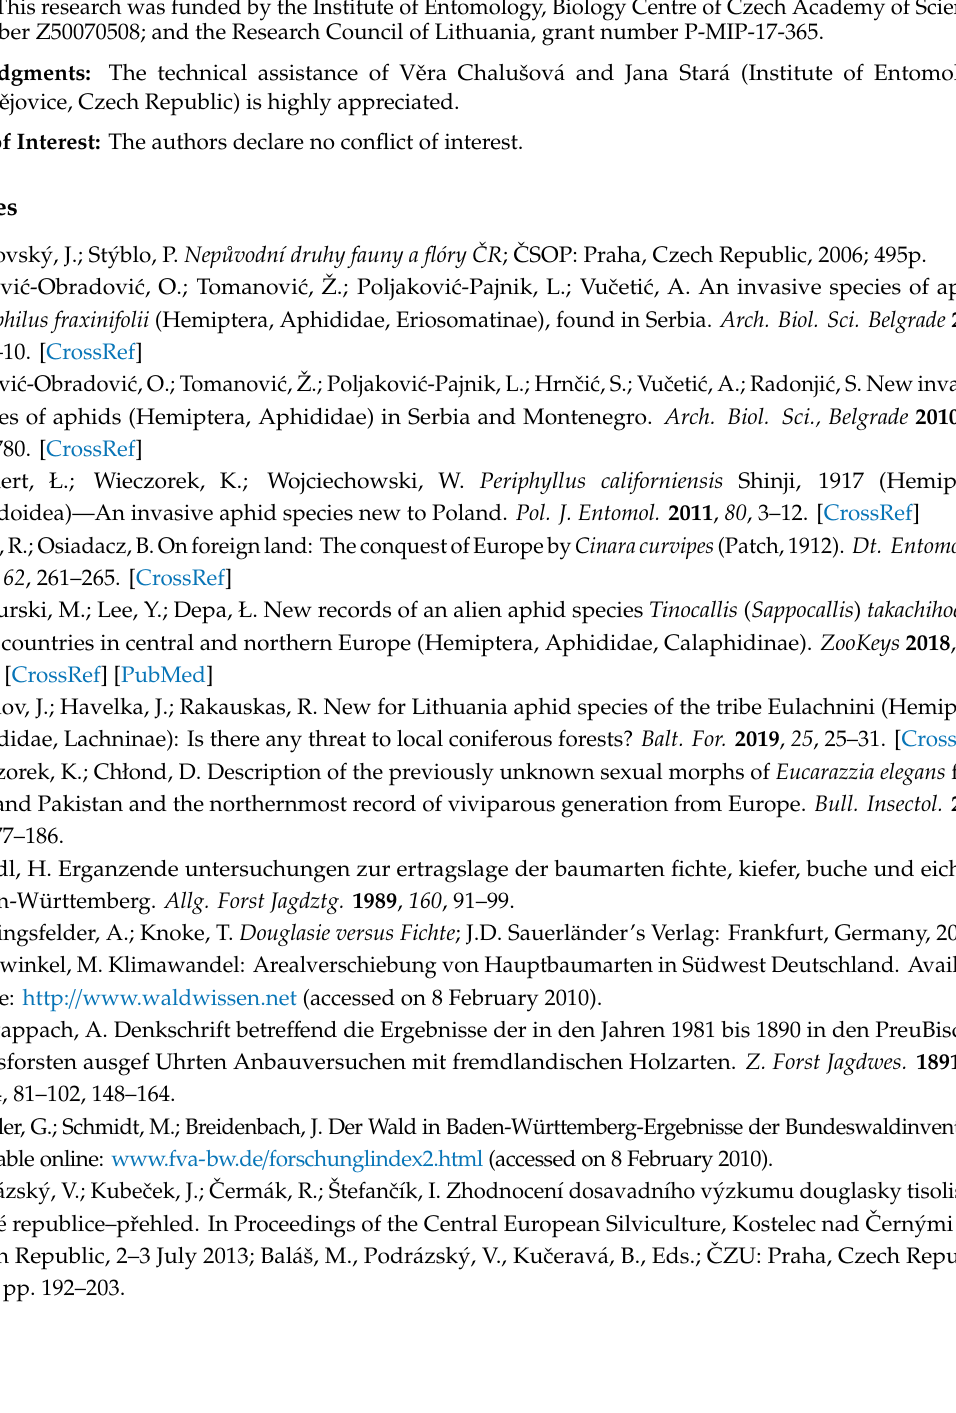
Table S1: General morphometric data of Cinara splendens samples from Czech